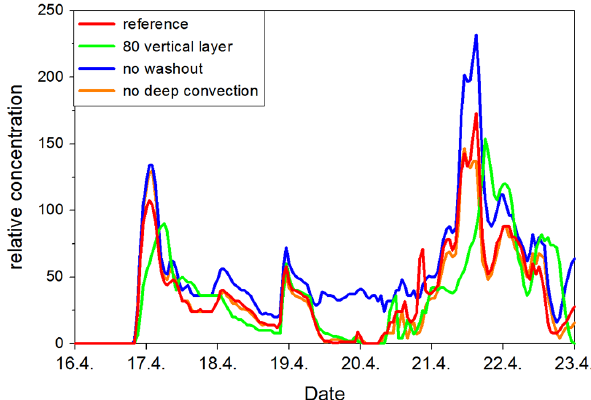
Figure 4. Temporal development of the non-calibrated simulated ash concentrations (arbitrary units) with a diameter of 1µm at Ho- henpeißenberg for the model configurations indicated in the legend.